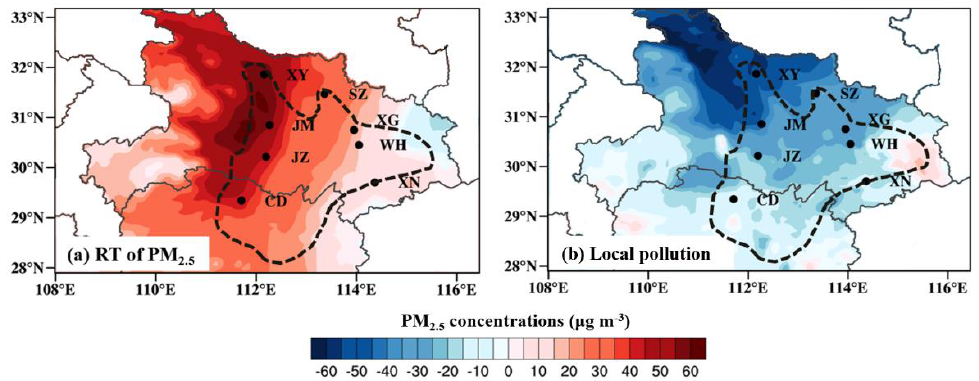
Figure 6. Distribution of near-surface PM 2.5 di ff erences concerning ( a ) regional transport and ( b ) local pollution,